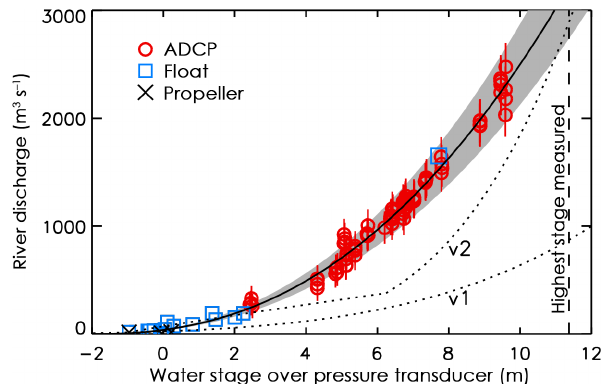
Figure 3. Measured Watson River discharge versus stage. Symbols denote discharge measurements by three methods. The black line represents the best power-function fit, and the grey area a 15% un- certainty range. Dotted lines illustrate earlier versions (v1 and v2) of the stage–discharge relation.